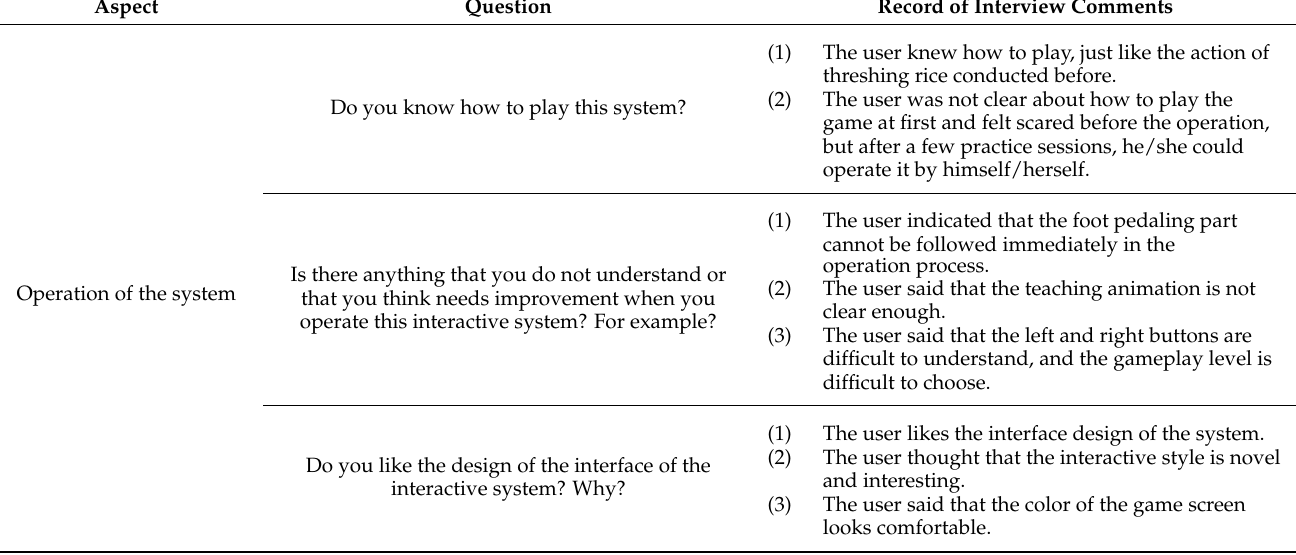
Table 7. The list of comments on the proposed system collected from interviews with the slightly disabled elderly users in the second field